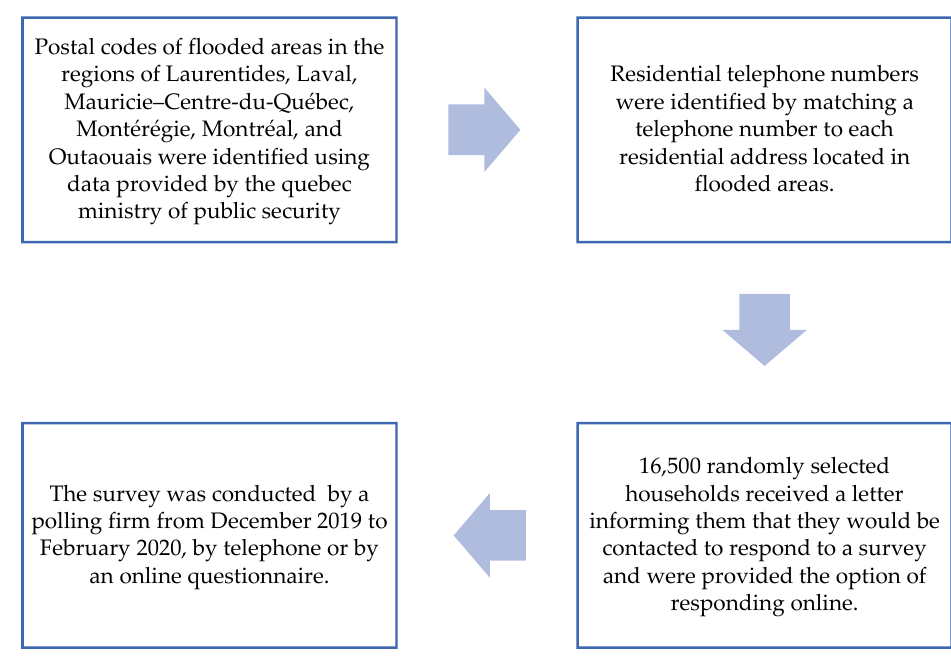
Figure 1. Methodology flow chart.